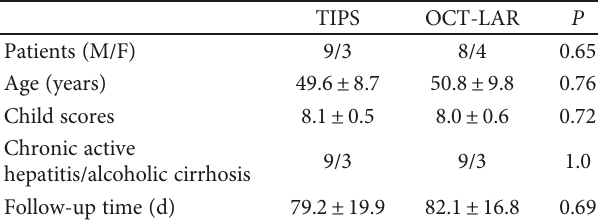
Table 1: Patient characteristics.